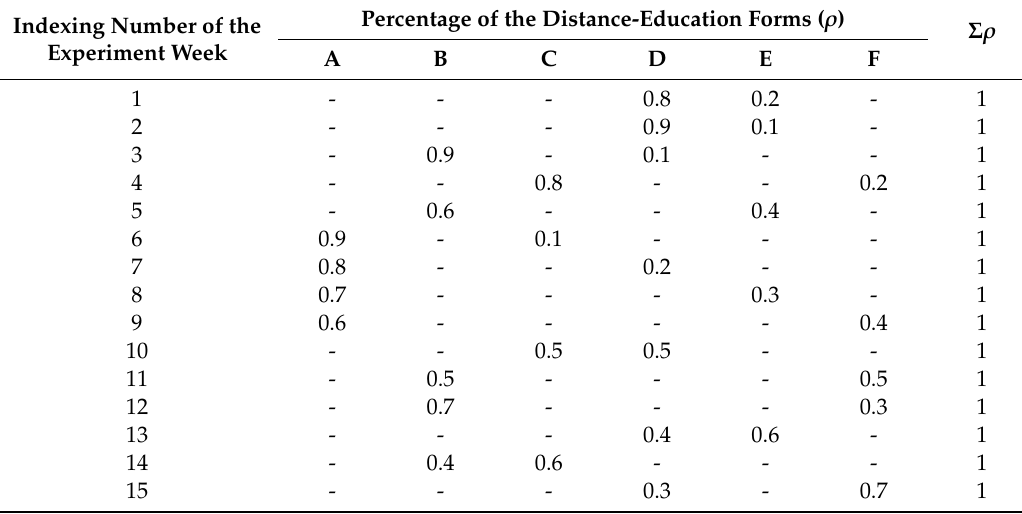
Table A4. Schedule for conducting an experiment to improve the distance-learning e ff ectiveness at the university: a case study of learning the discipline “Stability